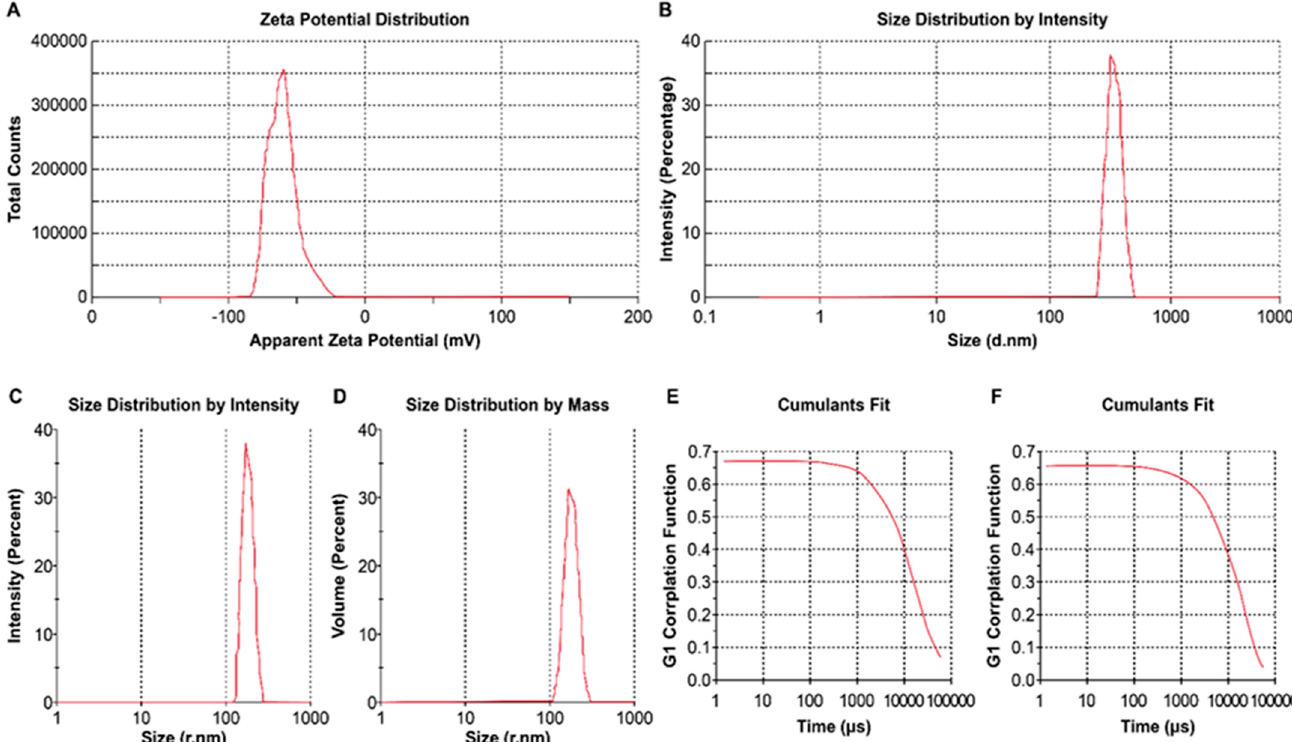
Figure 1. The physical characterization of lyophilized recombinant HBsAg–loaded docosahexaenoic acid nanovesicles. ( A ) Zeta potential of nanovesicles in the injectable formulation; ( B ) size distribution analysis by intensity in d. nm in the injectable formulation; ( C ) size distribution analysis in r.nm in the injectable formulation; ( D ) size distribution analysis by mass in the injectable formulation; ( E ) cumulative fit of particle size in an injectable formulation ( F ) distribution fit analysis of particles in the injectable formulation.